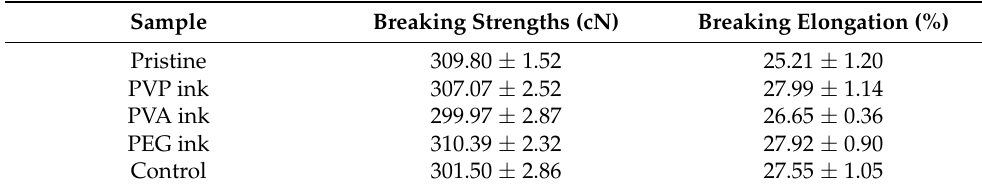
Table 6. Breaking strengths and breaking elongation of yarns of pristine polyester fabric and fabric printed with PVP ink, PVA ink, PEG ink, and control sample.